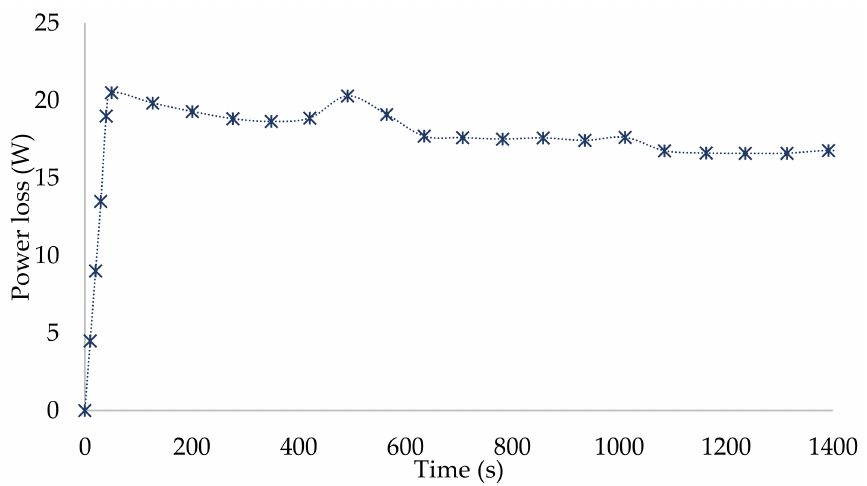
Figure 3. The power loss of the LiC single cell under fast charge/discharge with continuous 150 A current rate during 1400 s experimental test.